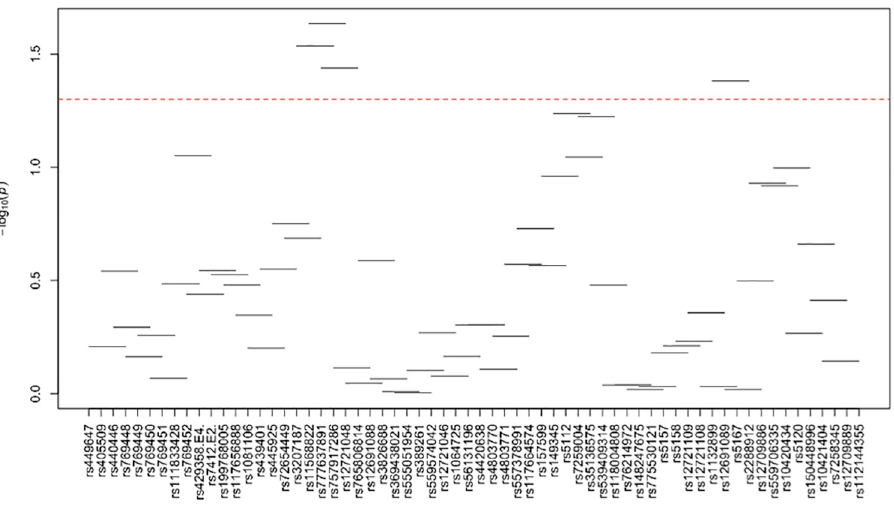
Fig 8. Plots of haplotype-based association analysis results for ApoA1 in NHWs. Horizontal lines represent the 4-SNP windows. X-axis direction shows the SNPs genotyped in the regions based on the order of APOE , APOC1 , HCR1 , HCR2 , APOC4 and APOC2 while the Y-axis shows the–log (global p-value) with red line representing the p- value threshold (P =